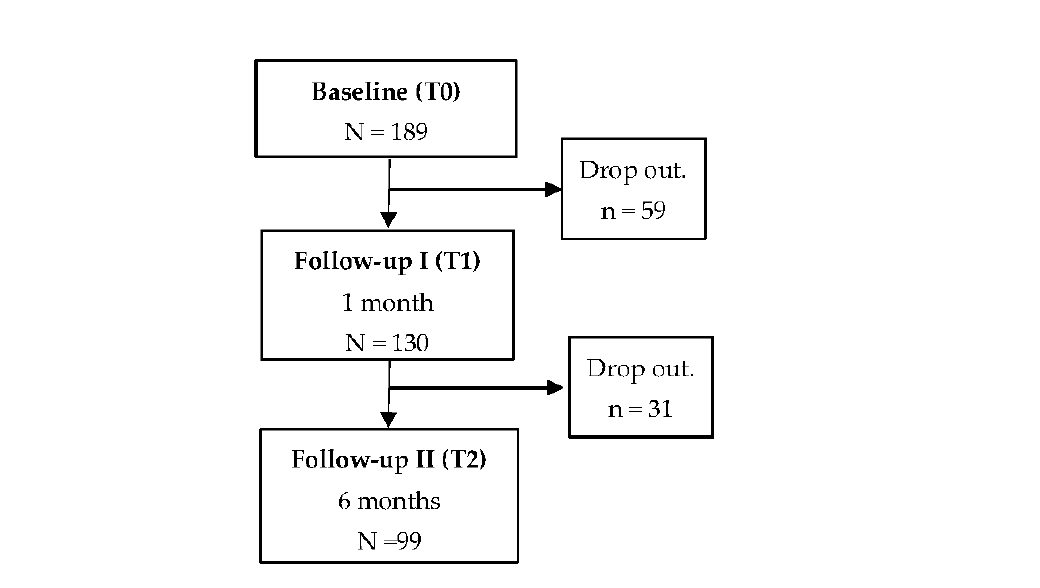
Figure 1. Number of participants in each stage of the study.